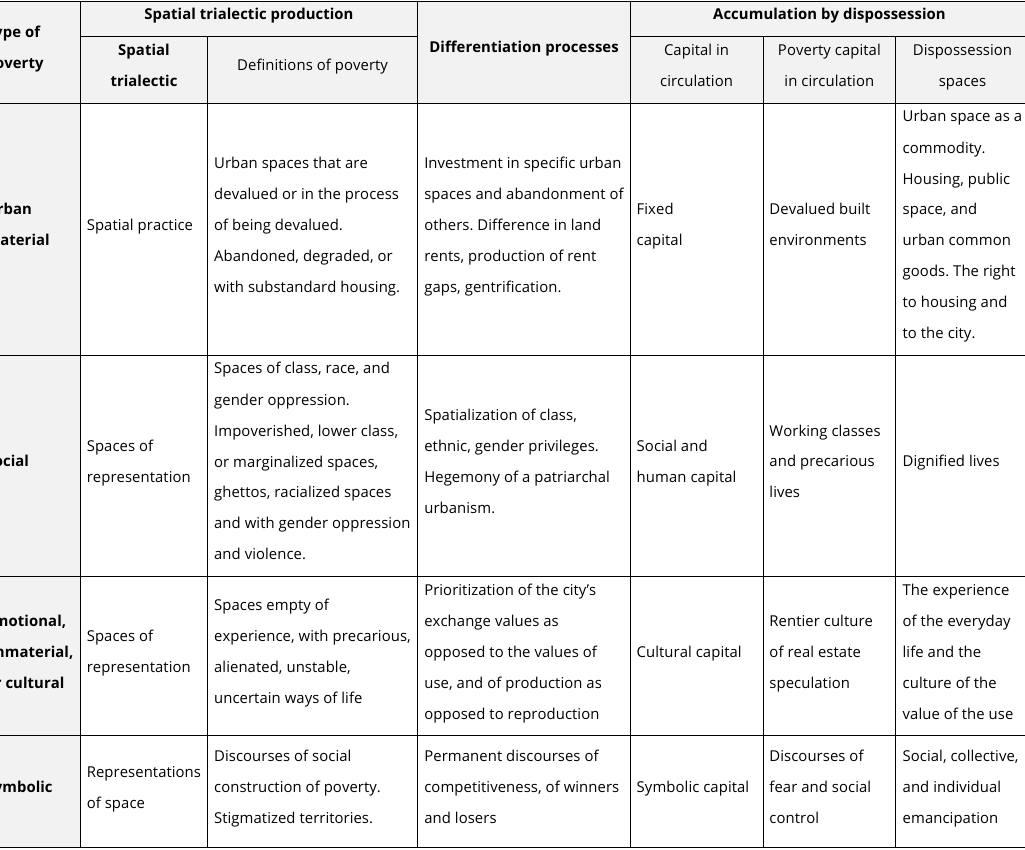
Table 1. Urbanization of poverty through spatial trialectic production, processes of differentiation and accumulation by